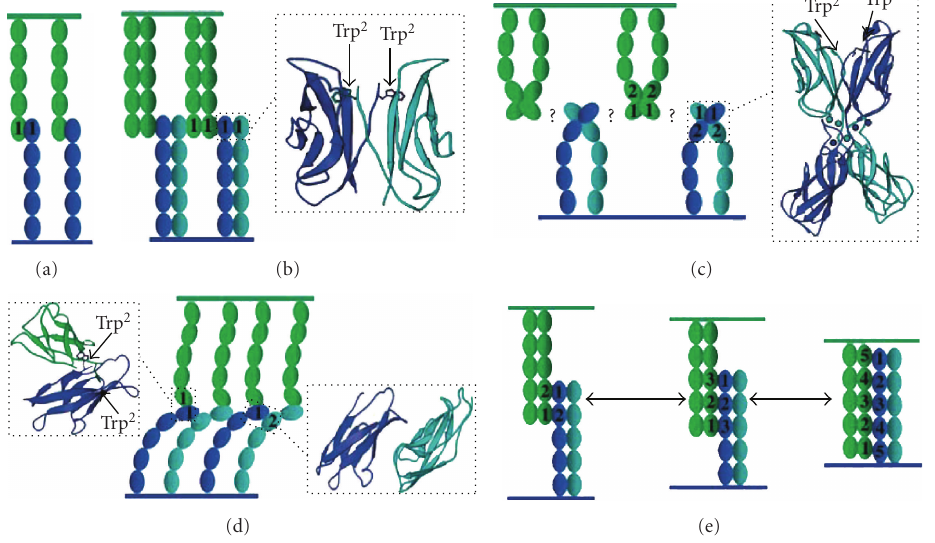
Figure 3: A visual representation of alternative desmosomal cadherin association models from the strand dimer (a), that consider the heterophilic interactions of desmosomal cadherins. Individual desmosomal cadherin ectodomains (1 to 5) are portrayed as ovals and are colored accordingly to clearly separate lateral from strand interactions. Identical color-coding is used to separate lateral and strand interactions in the ribbon representations. Cadherin ectodomains spanning from one cell surface are colored dark or light blue respectively and ectodomains spanning from an opposing cell surface are shown in green. (b) Cadherin dimerization via the surface of EC1 domains containing His 233 / Val 235 residues (residues not shown). Lateral dimers interact with strand dimers from an opposing cell. The insert shows a ribbon representation of the Trp 2 -mediated lateral-contact. (c) Lateral dimerization via EC1/EC2 calcium binding sites facilitated by the rod-like shape of cadherin ectodomains. The inset shows a ribbon representation of the domain pair dimer from the same cell surface, the position of the calcium ions are represented by spheres and are color coded dark or light blue to represent the cadherin ectodomains in c. (d) Lateral interaction at EC1 between strand dimers bound together by EC1 and EC2 interactions. The left inset is a ribbon representation of Trp 2 mediated contact between N-terminal domains; the right inset is a ribbon representation of lateral interactions between EC1 and EC2 domains. (e) Adhesive interactions between antiparallel cadherin molecules along their full length. Strand interactions occur between more than two EC domains resulting in the formation of three types of adhesive complexes of di ff erent length. Modified from [53] with permission from Birkh¨auser Verlag